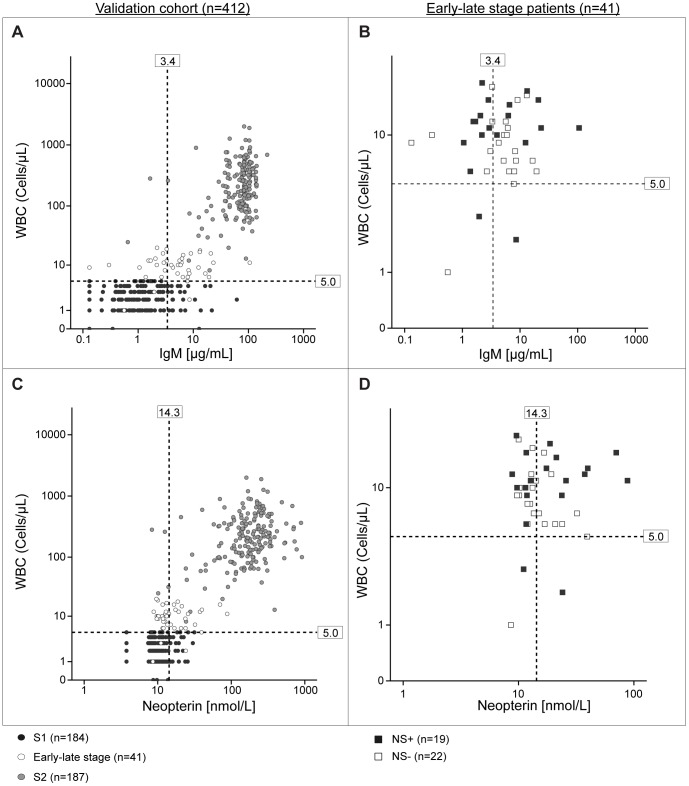
Classification of HAT patients according to WBC and IgM, or according to WBC and neopterin.A) Comparison of the classification of HAT patients (validation cohort) according to WBC and IgM. The staging cut-off of 5 WBC/µL recommended by WHO is reported on the graph as well as the staging cut-off of 3.4 µg/mL for IgM calculated on the training cohort. Black dots represent stage 1 patients, white dots represent early-late stage patients and gray dots represent stage 2 patients. B) Detailed classification of early-late stage patients (n = 41) according to IgM. Colours indicate the absence (white) or presence of neurological (black) signs. The staging cut-off of 5 WBC/µL recommended by WHO is reported on the graph as well as the staging cut-off of 3.4 µg/mL for IgM calculated on the training cohort. C) Comparison of the classification of HAT patients (validation cohort) according to WBC and neopterin. The staging cut-off of 5 WBC/µL recommended by WHO is reported on the graph as well as the staging cut-off of 14.3 nmol/L for neopterin calculated on the training cohort. Black dots represent stage 1 patients, white dots represent early-late stage patients and gray dots represent stage 2 patients. D) Detailed classification of early-late stage patients (n = 41) according to neopterin. Colours indicate the absence (white) or presence (black) of neurological signs. The staging cut-off of 5 WBC/µL recommended by WHO is reported on the graph as well as the staging cut-off of 14.3 nmol/L for neopterin calculated on the training cohort. NS+: presence of neurological signs; NS-: absence of neurological signs.